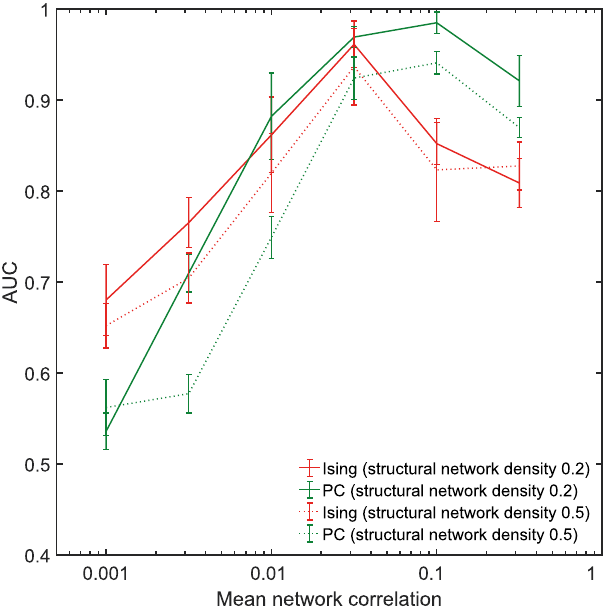
Figure 5. Effect of network density. Plot of the AUC values of Ising couplings and partial correlations for two different network densities and a fixed firing rate of 20 Hz and varying correlation levels. Data was averaged over ten scale-free networks of 30 nodes.